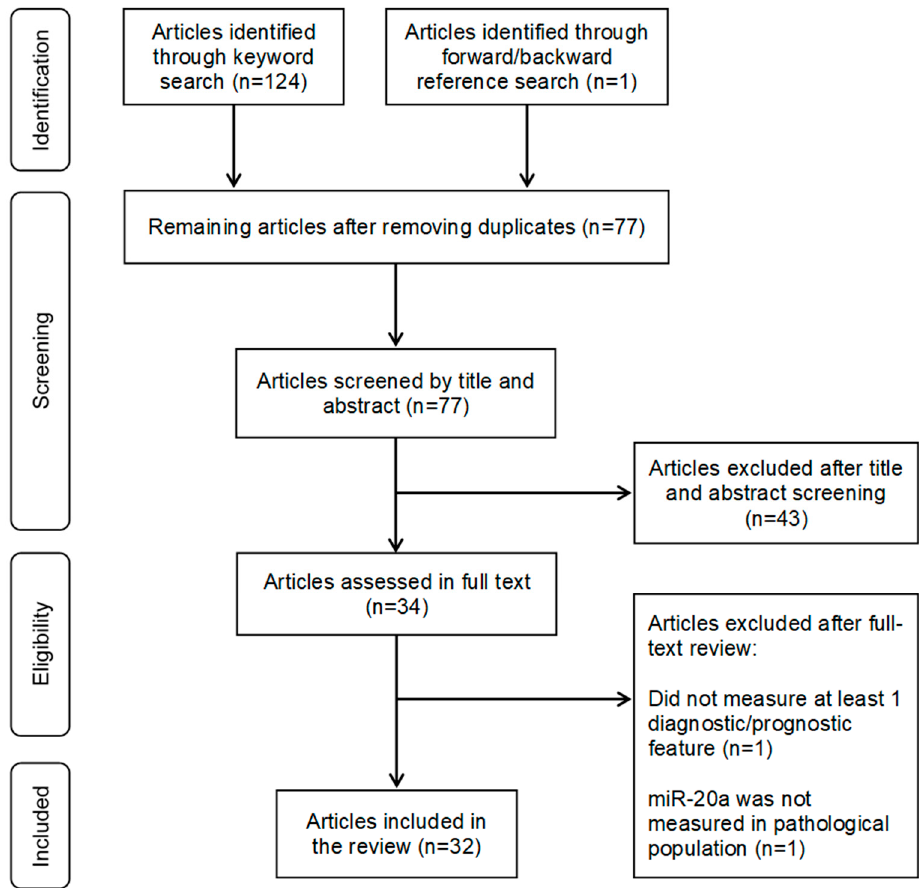
Figure 1. Flowchart of the literature search and selection process of eligible studies.